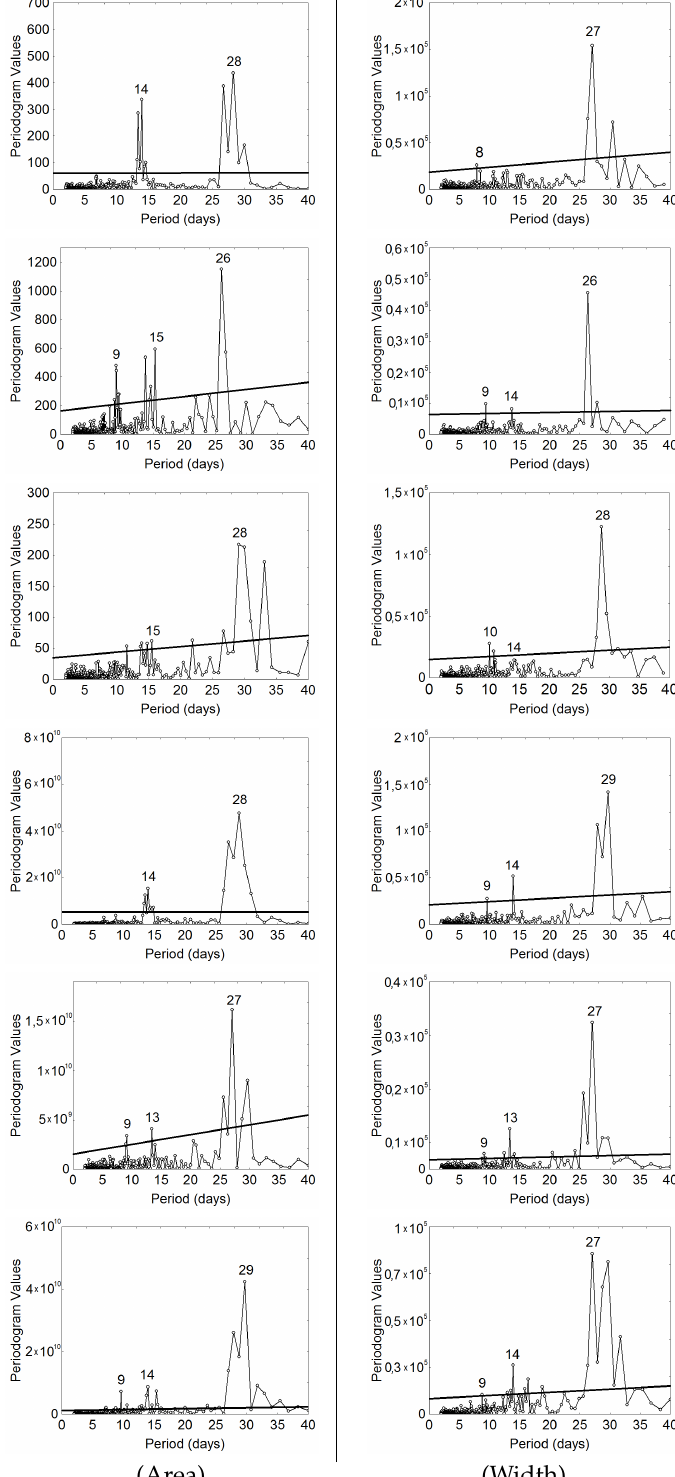
Figure 5. Columns ( Area ) and ( Width ) represent Fourier spectra for areas and longitudinal width variations in the analyzed CHs. Plots in the figure located in the following order from top to bottom: first—CHIMERA north; second—CHIMERA equator; third—CHIMERA south; fourth—RGA north; fifth—RGA equator; sixth—RGA